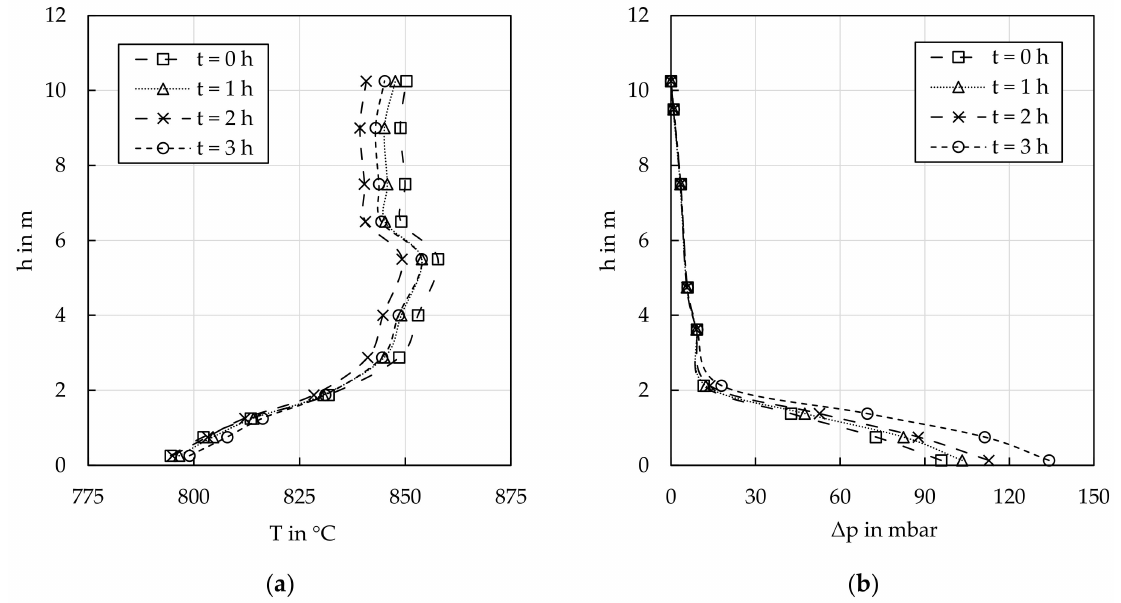
Figure 9. Calciner temperature ( a ) and pressure ( b ) profiles measured during solid recovered fuel